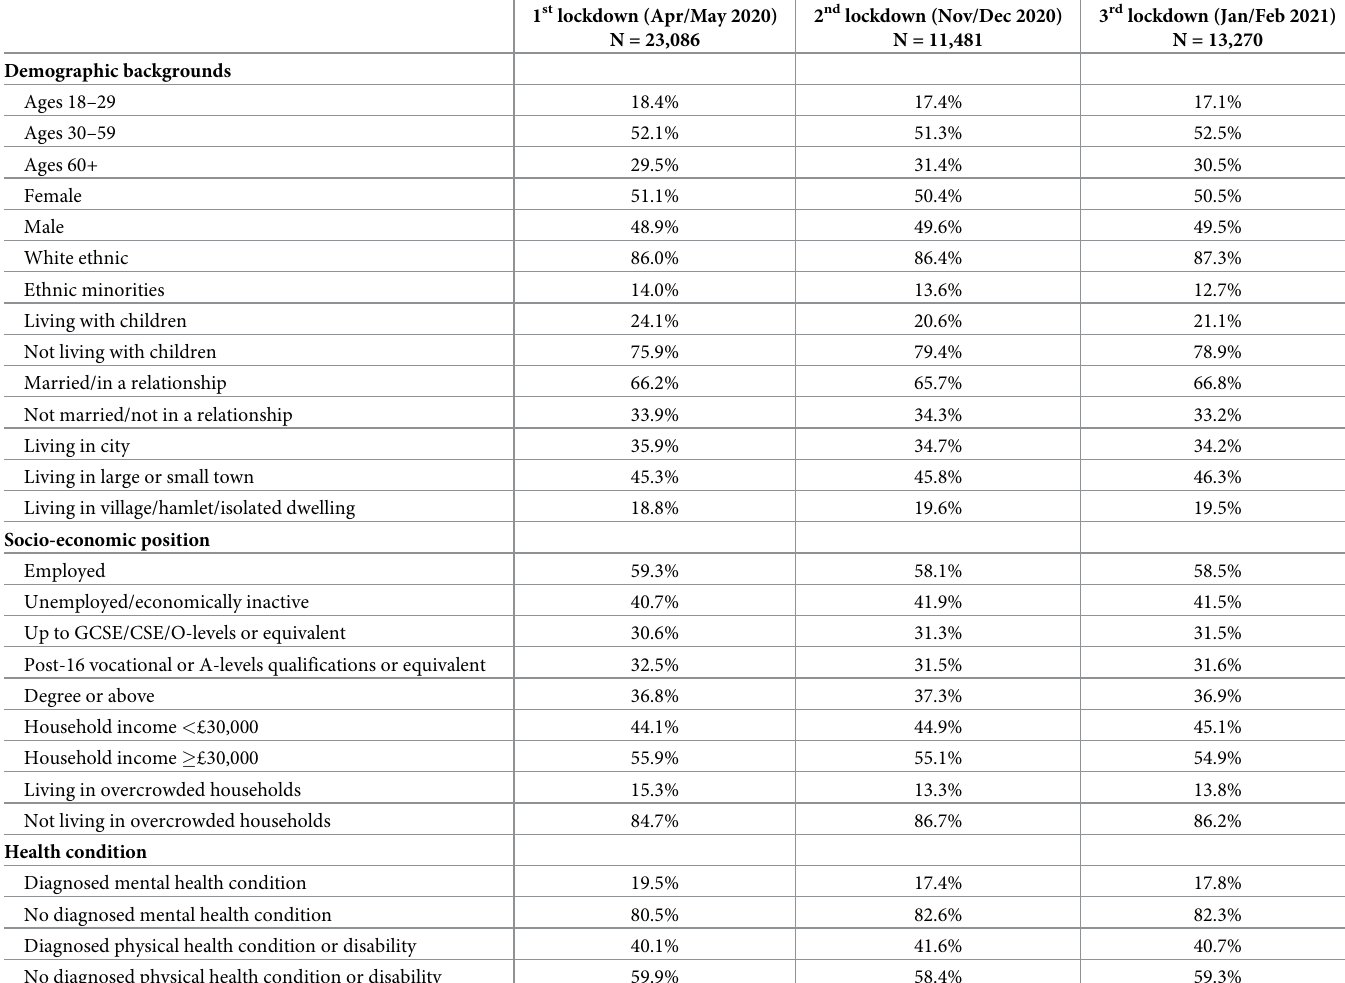
Table 1. Descriptive statistics